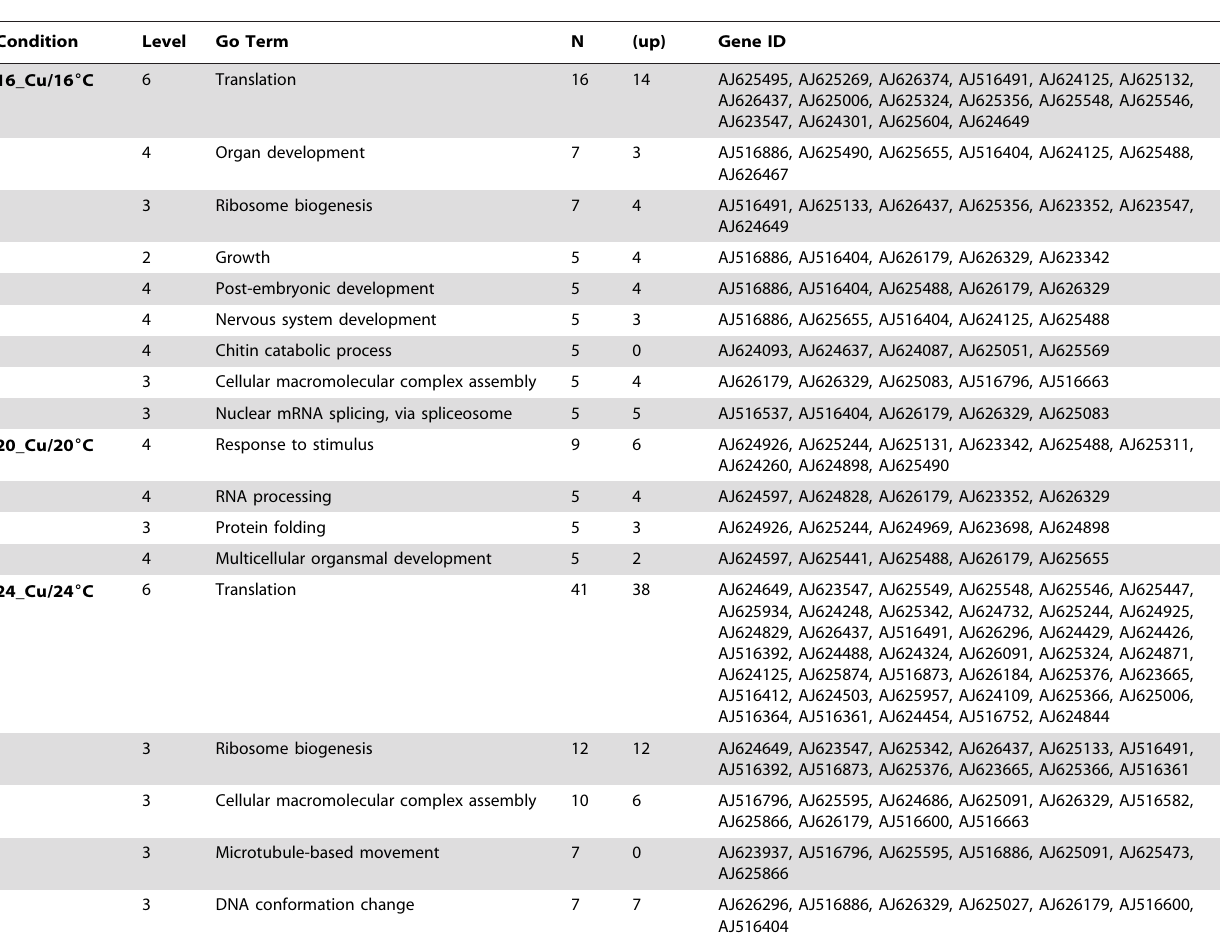
Table 3. GO term over-representation analysis of DEGs in the gills tissue of mussels exposed to copper along with heat stress.